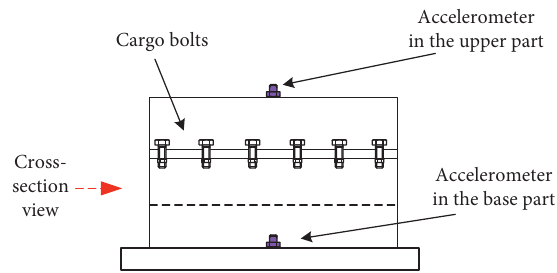
Figure 2: Enlarged view of the clamping support structure with cargo bolts.